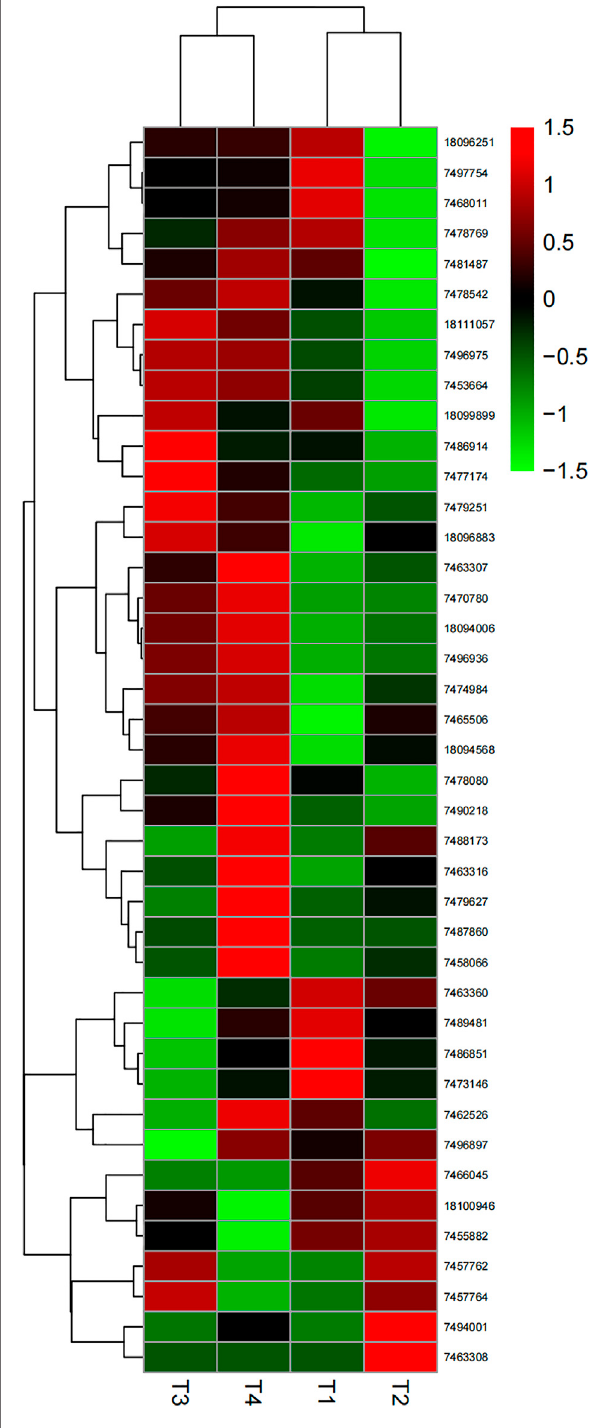
Frontiers in Genetics |